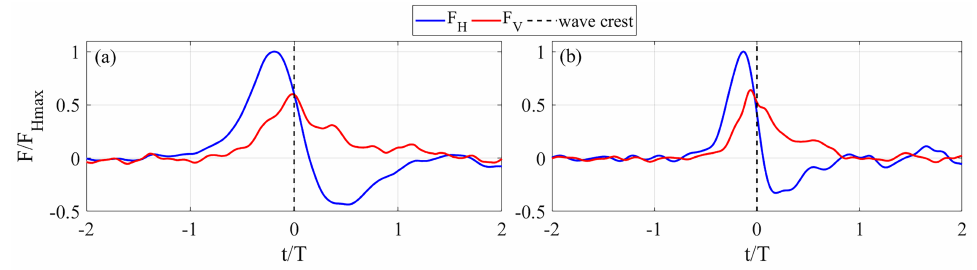
Figure 6. Time variation of horizontal F H and vertical F V wave forces vs. A / d . ( a ) Test no. 8; ( b ) test no. 18.